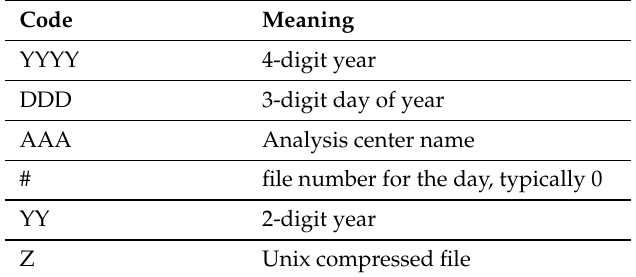
Table 3. IGS IONO WG VTEC address elements